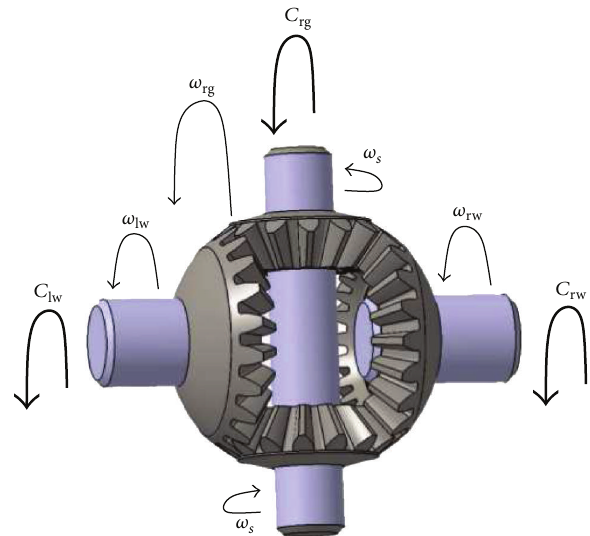
Figure 4: Angular velocities and torques in the differential